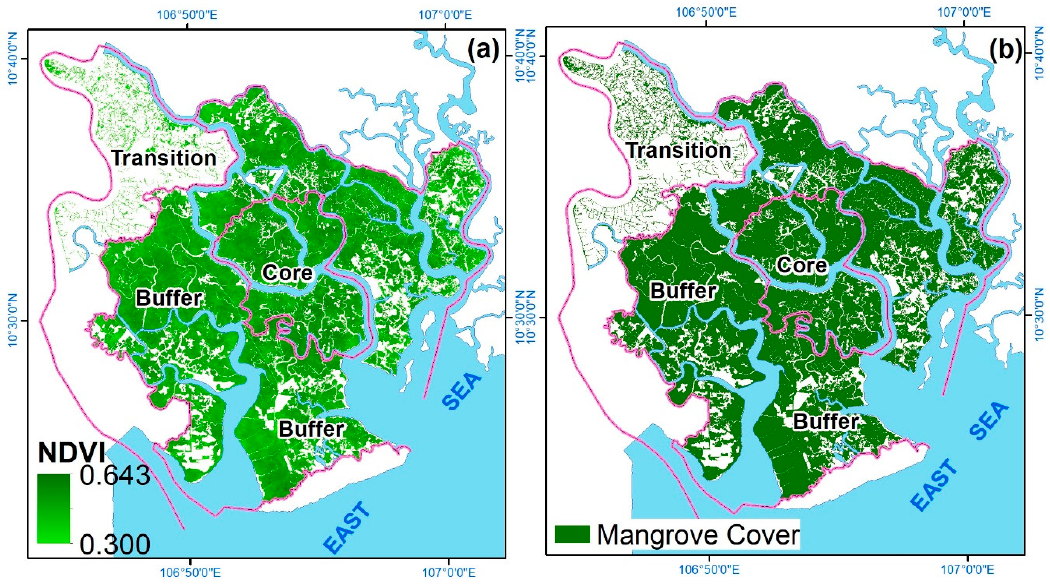
Figure 3. A comparison between ( a ) mangrove cover derived from NDVI value and ( b ) reference map of mangrove forests in 2015.